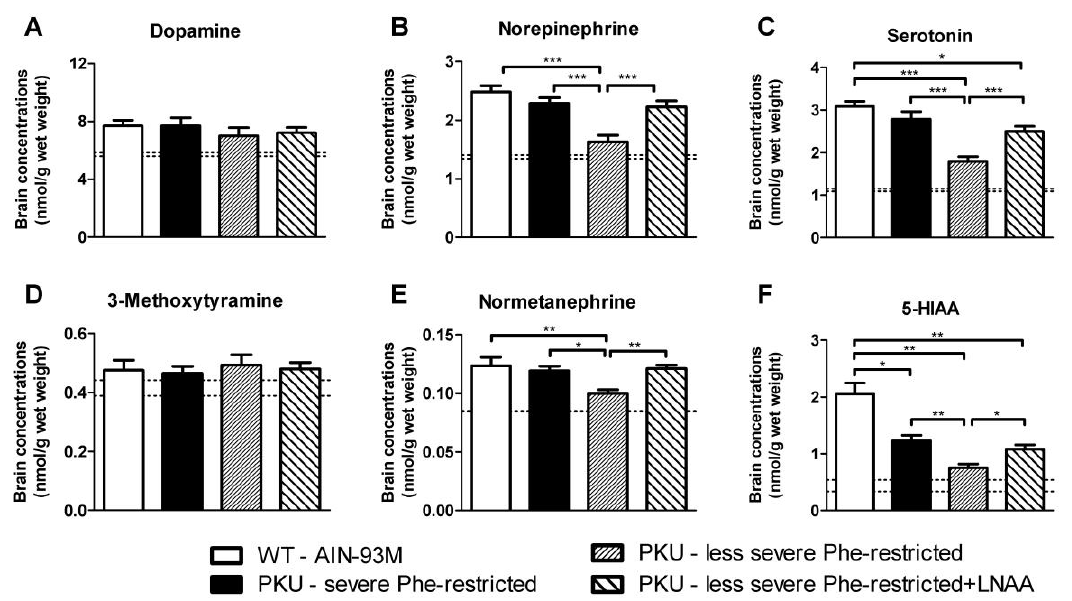
Figure 3. Brain concentrations of ( A ) dopamine, ( B ) norepinephrine, ( C ) serotonin, ( D ) 3-methoxytyramine, ( E ) normetanephrine, and ( F ) 5-hydroxyindoleacetic acid (5-HIAA) in WT and PKU mice after six weeks of receiving various diets. Numbers of mice are n = 10 for all experimental groups. Untransformed data are expressed as mean ± SEM. * p < 0.05; ** p < 0.01; *** p < 0.001 (two-sided). For comparison, dashed lines represent mean brain monoamine concentrations obtained in C57Bl / 6 PKU mice on AIN-93M diet in previous experiments [9,23]. Previously obtained mean brain monoamine concentrations in PKU mice on the AIN-93M diet were expressed as proportion of data in respective WT mice and then multiplied by mean brain monoamine concentrations of WT mice in the present study.